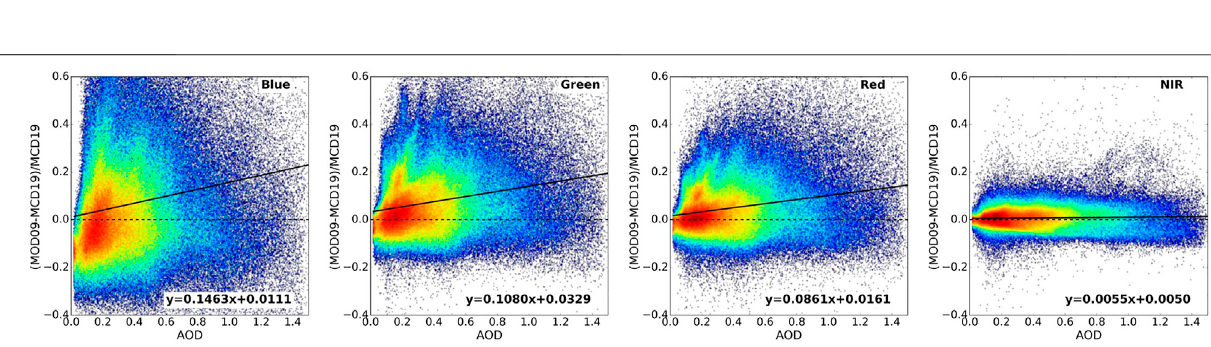
Frontiers in Remote Sensing |